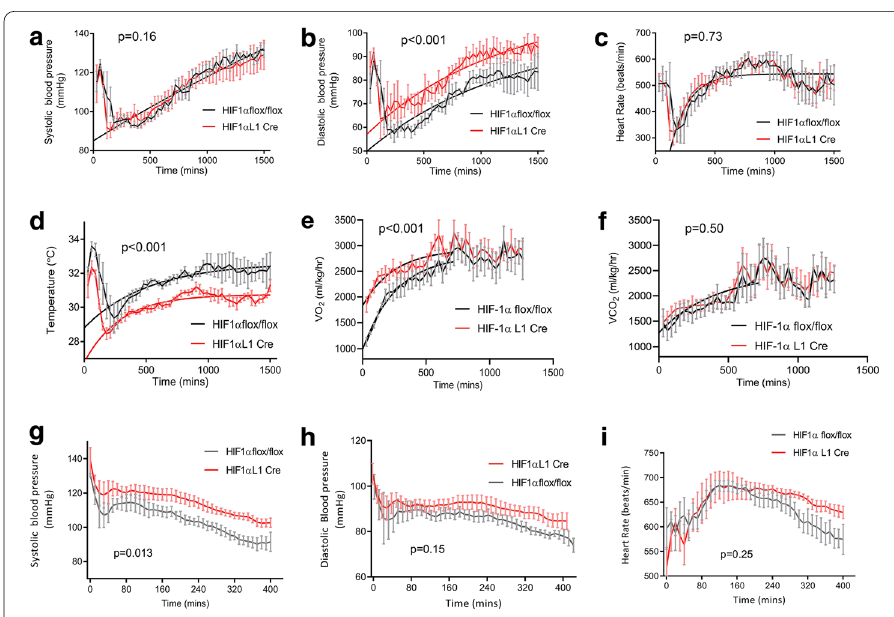
Fig. 4 Effects of HIF-1α pulmonary endothelial knockout on response to acute hypoxia and inflammatory stress. Impact of acute hypoxia with inspired oxygen concentration of 10% on a systolic ( p blood pressure ( p < 0.001), c heart rate ( p consumption ( p < 0.01) and f carbon dioxide synthesis ( p HIF-1α flox/flox (grey,